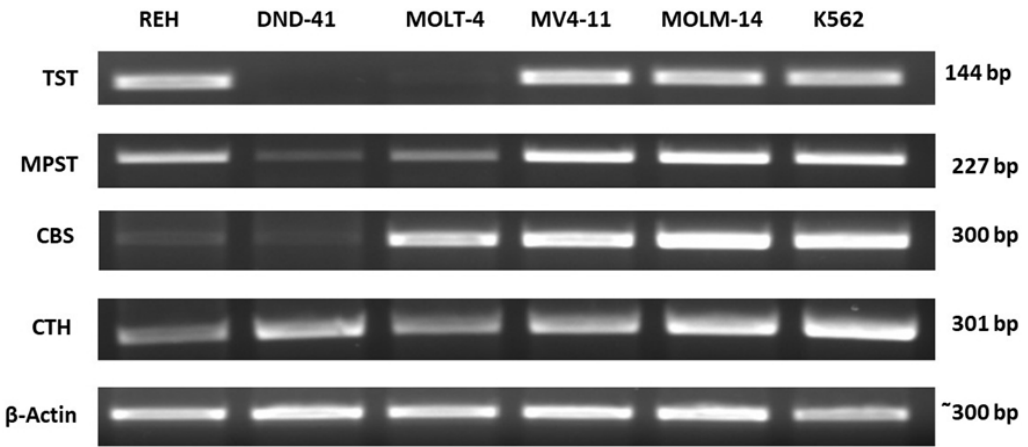
Figure 2. The expression of TST, MPST, CBS, and CTH on the mRNA level in leukemia cell lines (RT-PCR analysis). β -Actin was used as the loading control. Data from a representative experiment are presented. All the experiments were repeated at least three times with similar results.